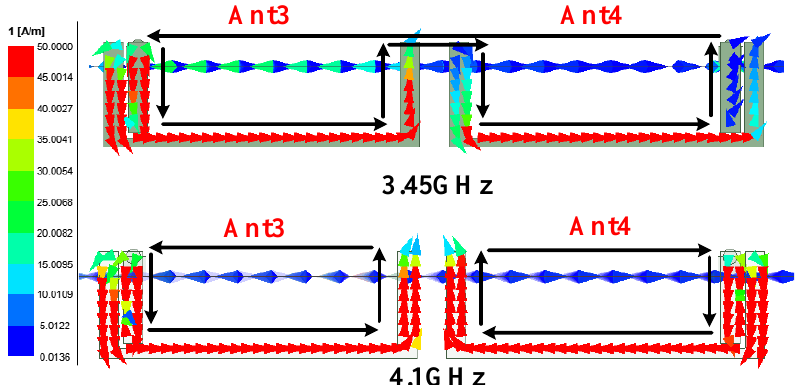
Figure 7. Simulated current distributions of Ant3 and Ant4 with port 3 excitation at 3.45 and 4.1 GHz when L 1 = 0 mm.